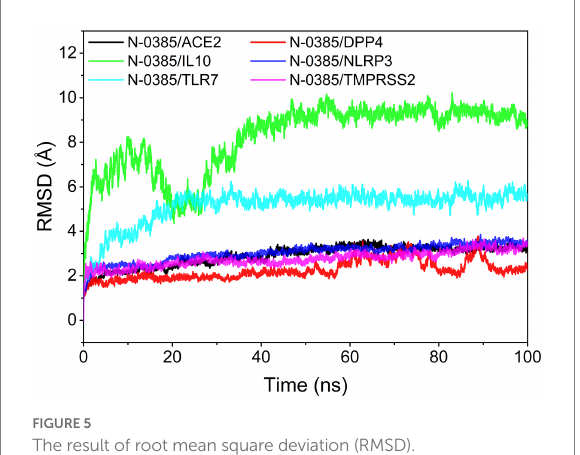
FIGURE 5 The result of root mean square deviation (RMSD).